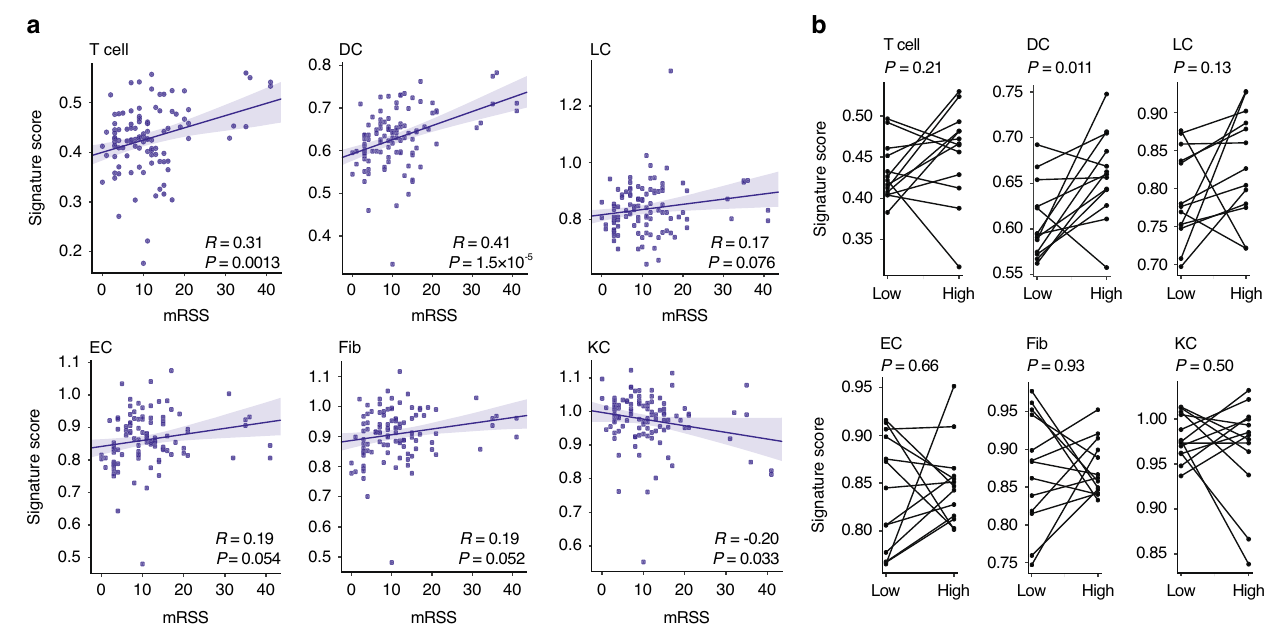
Fig. 3 Pathogenic effects of different cell types to SSc. ( a ) Scatter plots showing the average expressions of the cell type signature genes (de fi ned in HOMER) for T cells (CD4 + and CD8 + T cells), DC (dendritic cells), LC (Langerhans cells), EC (endotheliocytes), Fib ( fi broblasts), KC (keratinocytes), versus the corresponding mRSS (modi fi ed Rodnan skin score) of the same patient at the same time point during the treatment. Gene expression pro fi les were obtained from patients ’ affected skin cells via microarray, and genes responding to mycophenolate mofetil (MMF) treatment were discarded. The linear regression curve and 95% con fi dence interval (grey area) were also illustrated in each panel, two-tailed t-statistic P -value and coef fi cient (R) of Pearson ’ s correlation were shown in the bottom right. Source data are provided as a Source Data fi le. ( b ) Pair-wise comparison of the average expressions of cell type signature genes at time point with the lowest versus highest mRSS of the same patient for all the six-cell types measured. For each patient during the treatment, we identi fi ed the time points when the mRSS score is the lowest (time point Low) and highest (time point High), and then calculated the corresponding signature scores for each cell type from the microarray pro fi les at time point Low and time point High, respectively. The time points Low and High can be different for different patients. 13 patients whose highest mRSS - lowest mRSS > 5 were shown, P values were estimated by paired and two-tailed Student ’ s t test. Source data are provided as a Source Data fi